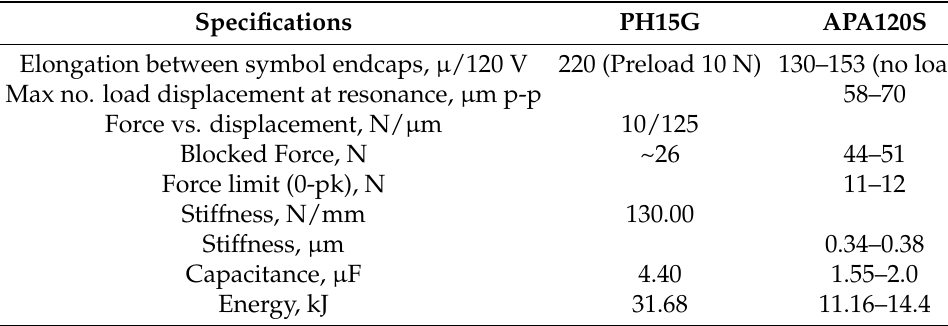
Table 1. Specification comparison for the PowerHap 15G and APA120S piezo